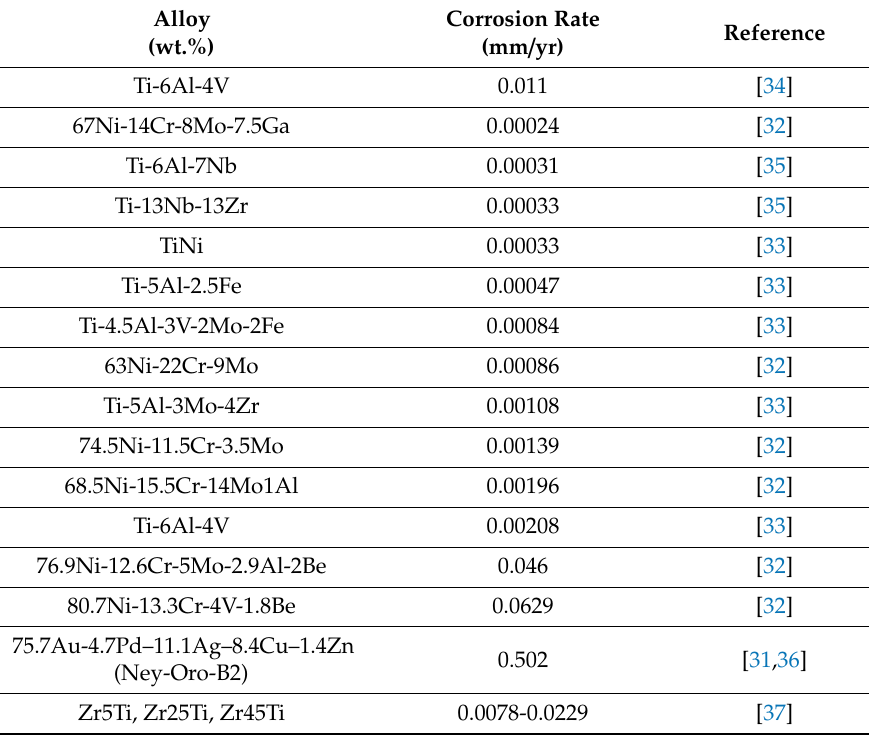
Table 3. Corrosion rates of selected dental